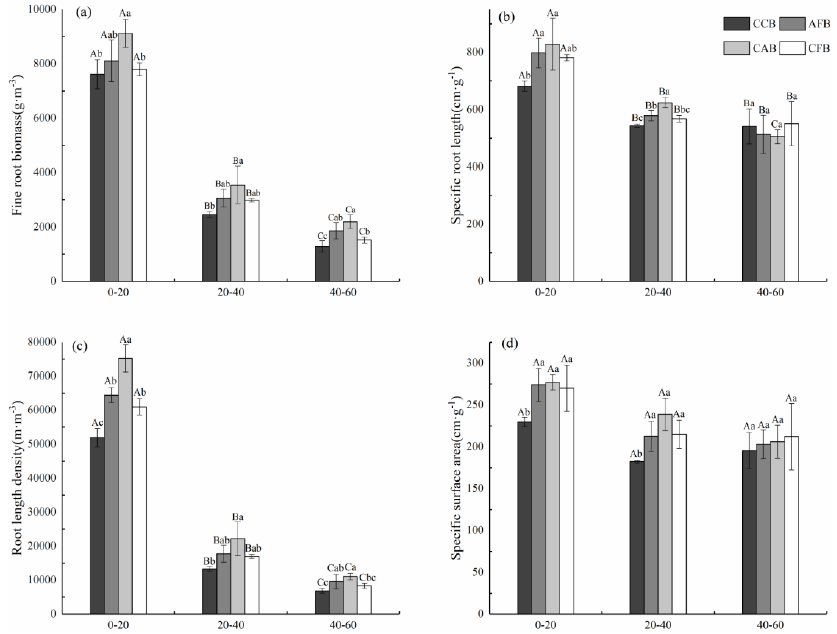
Figure 3. ( a ) Fine root biomass, ( b ) specific root length, ( c ) root length density and ( d ) specific surface area in mixed forest of bamboo–broadleaved trees. Error bars indicate the standard deviation (n = 3). Capital letters indicate the difference in fine root characteristics between different soil layers under the same stand ( p < 0.05); lowercase letters indicate differences in fine root characteristics between different stands in the same soil layer ( p < 0.05).